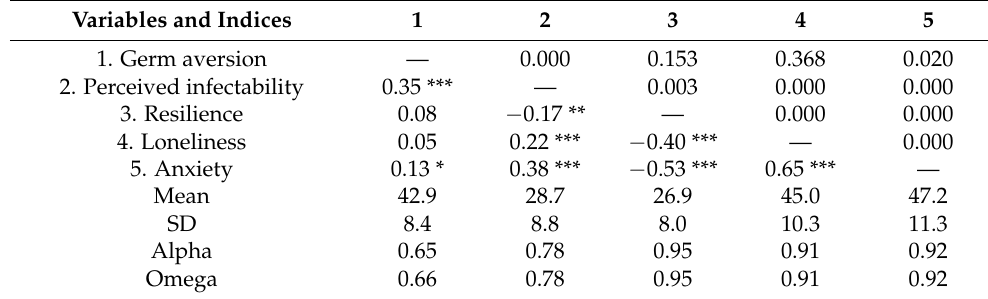
Table 1. Intercorrelations between variables, reliabilities, and descriptive statistics.